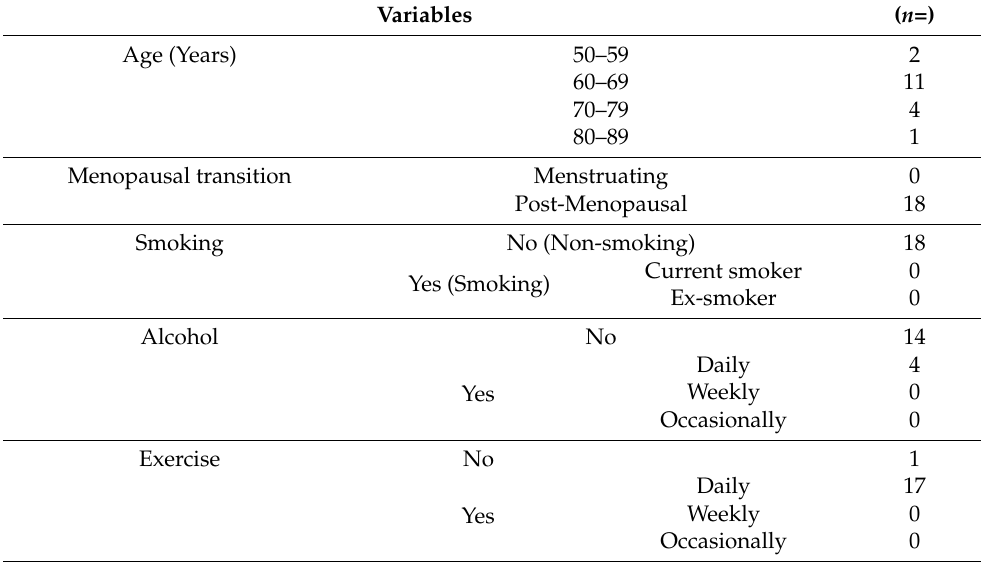
Table 1. The characteristics of participants in the baseline.